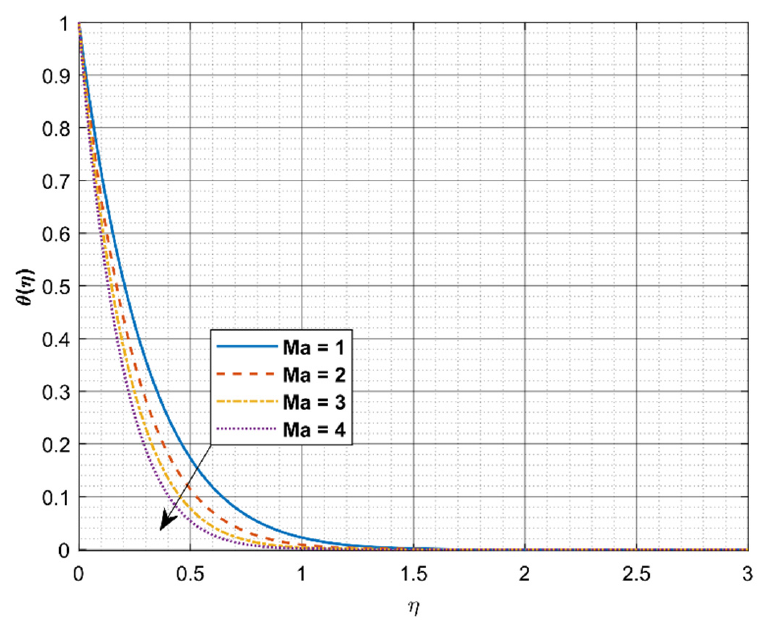
θη . Figure 7. Influence of Ma on θ ( η ) θη .